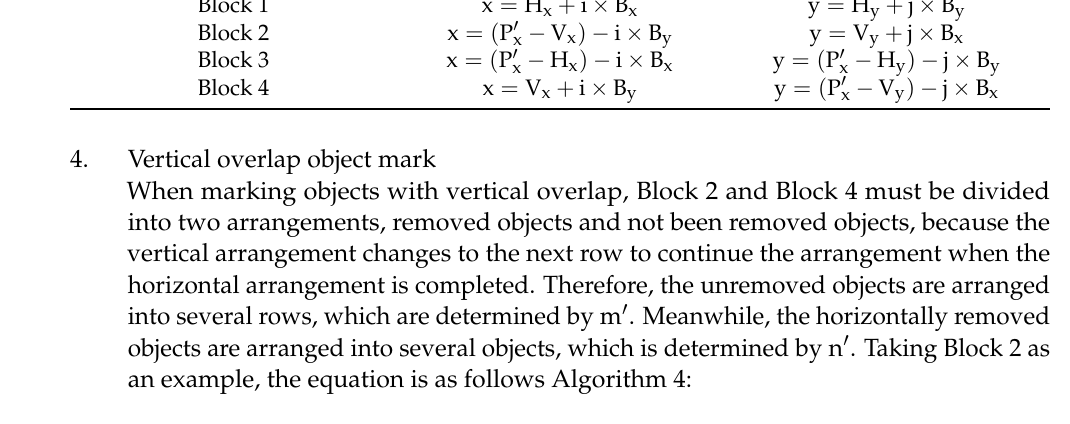
Figure 20. Staggered stacking.